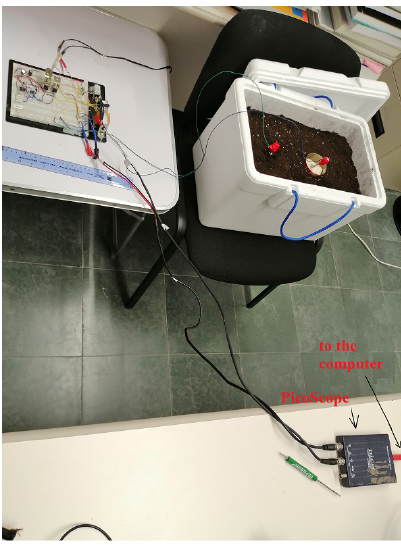
Figure 6. Experimental soil platform: ( a ) a photo of an electrode; ( b ) a photo of both electrodes and the aluminum container; and ( c ) a front view of the realization.